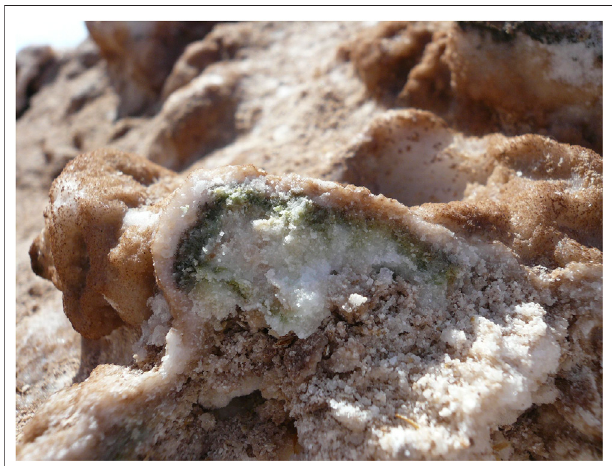
FIGURE12| Colonizedhalites inYungay. Notethegray/greenishlayera few mm below the arti fi cially fractured halite surface.